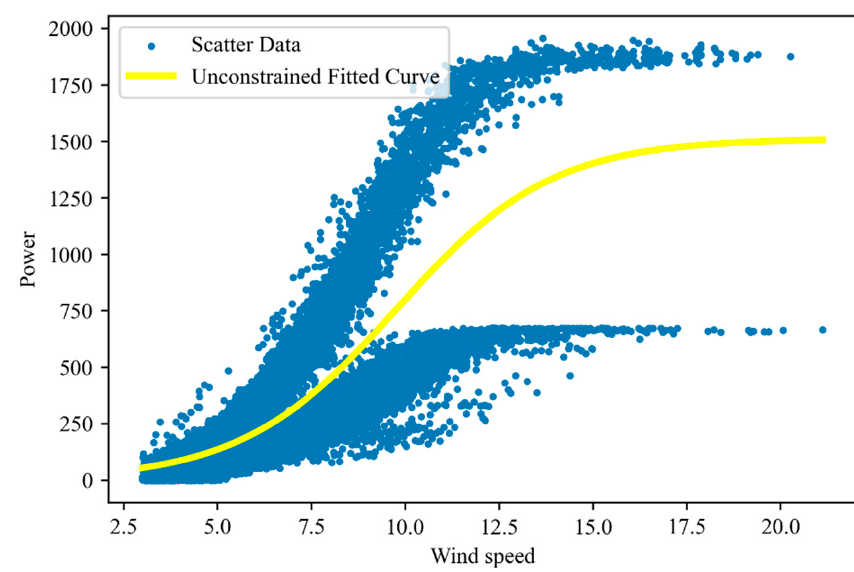
Figure 4. The unconstrained curve fitting error under the influence of abnormal data.